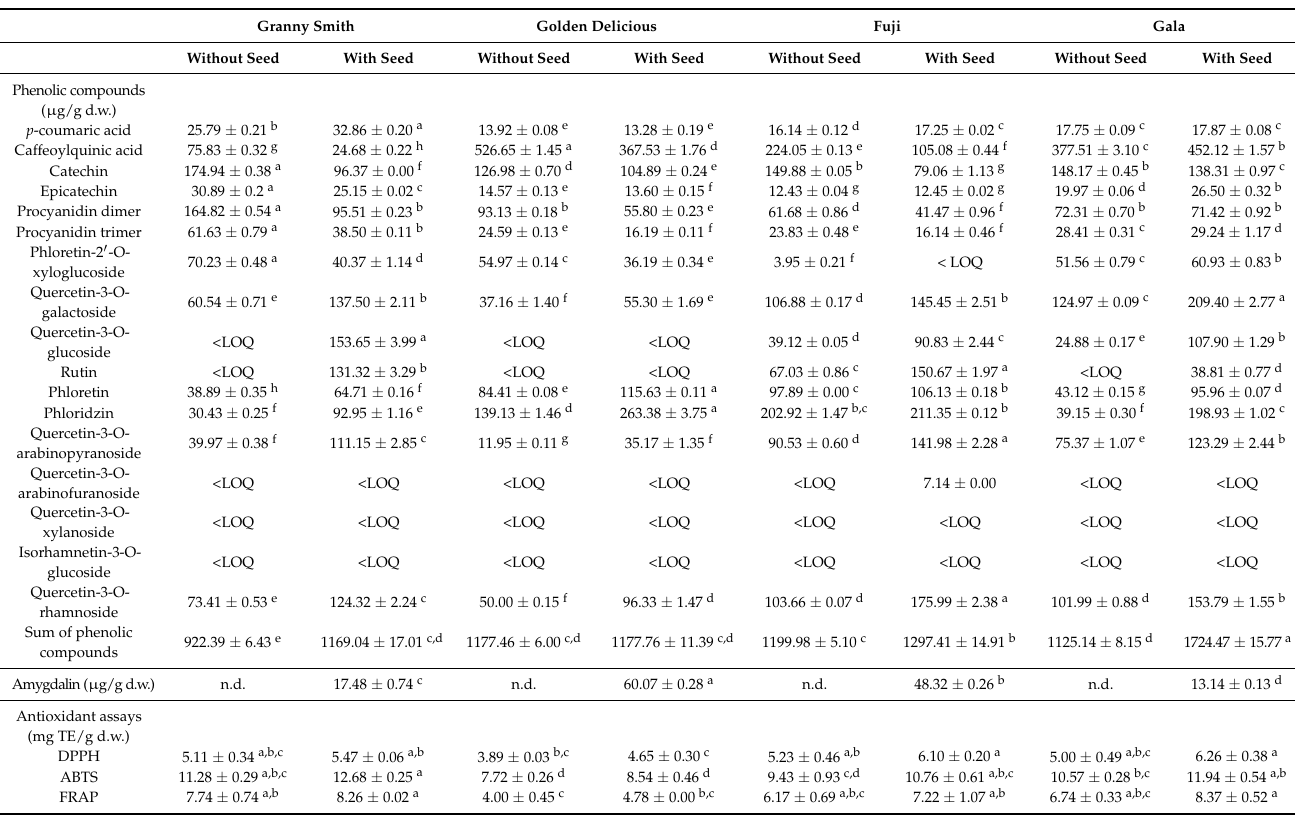
Table 5. Comparison of different apple pomace extracts from different varieties obtained in the optimal conditions expressed as the average and the standard